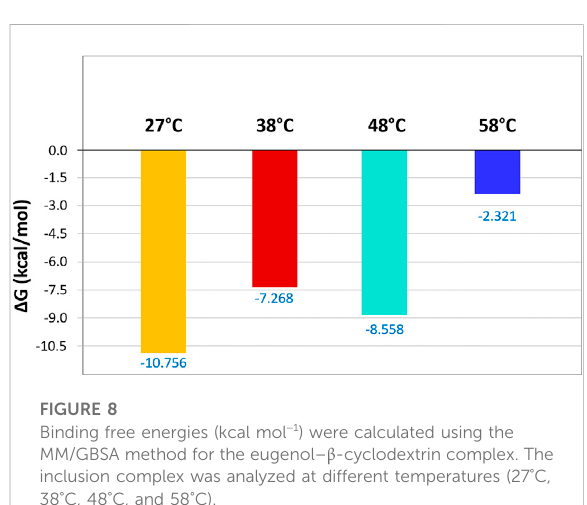
FIGURE 8 Binding free energies (kcal mol − 1 ) were calculated using the MM/GBSA method for the eugenol – β -cyclodextrin complex. The inclusion complex was analyzed at different temperatures (27 ° C, 38 ° C, 48 ° C, and 58 °